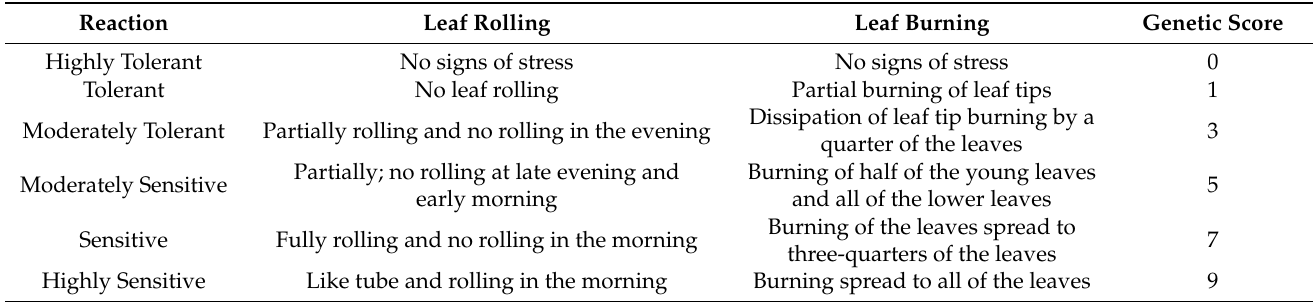
Table 3. Instructions for determining the response to drought